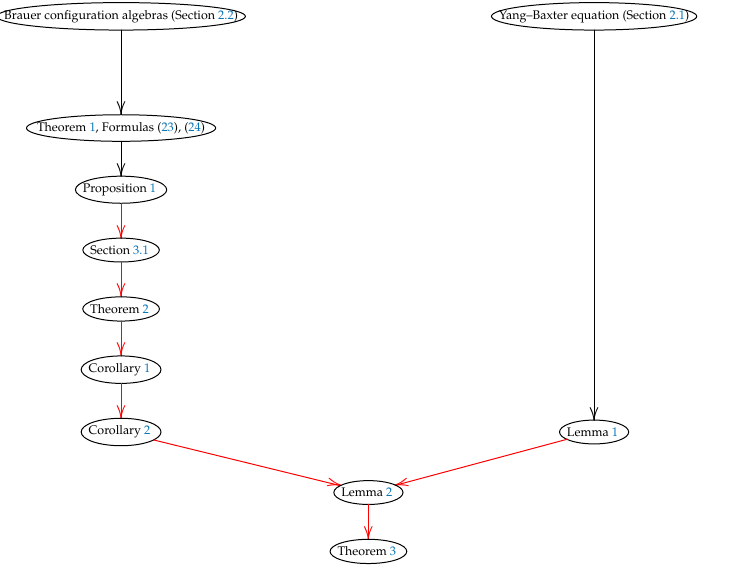
Figure 1. Main results presented in this paper (targets of red arrows) allow establishing a connection between Brauer configuration algebras and YBE